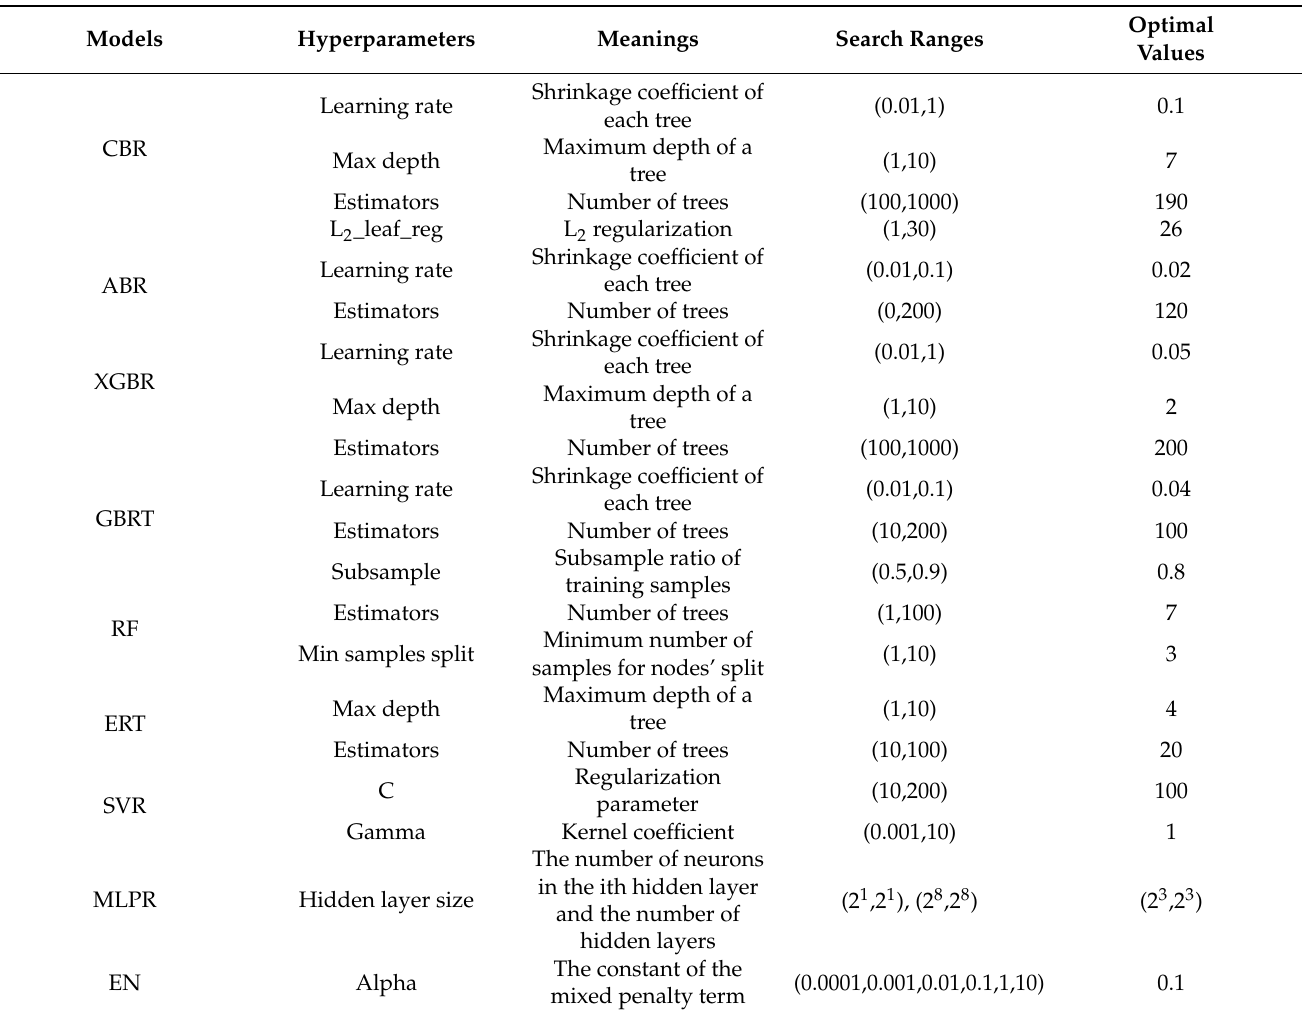
Table 3. Tuned hyperparameters and their settings for each model in the prediction of